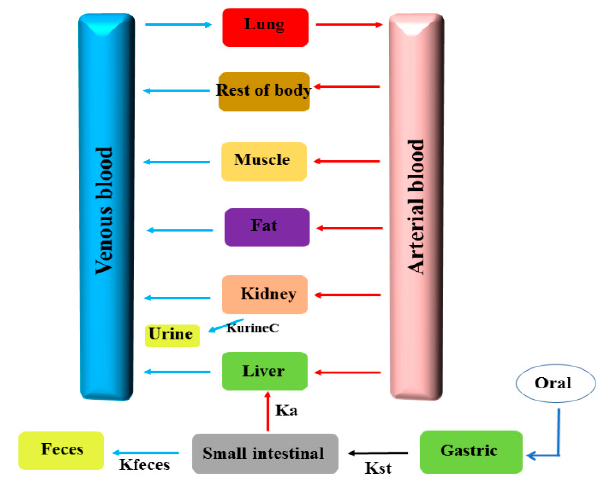
Figure 2. The schematic of the PBPK model for ENR in pig.